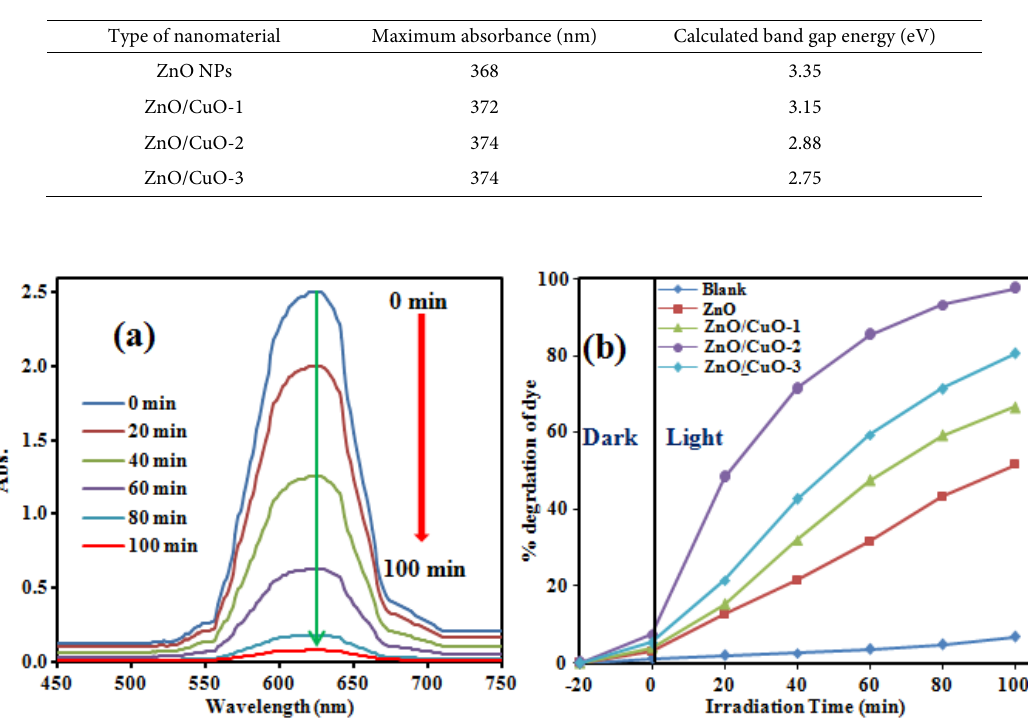
Fig.7. (a) UV–vis absorption spectra showing degradation of Brilliant cresyl blue (BCB) with ZnO/CuO nanocomposite (b) The % degradation of BCB dye by ZnO NPs and ZnO/CuO